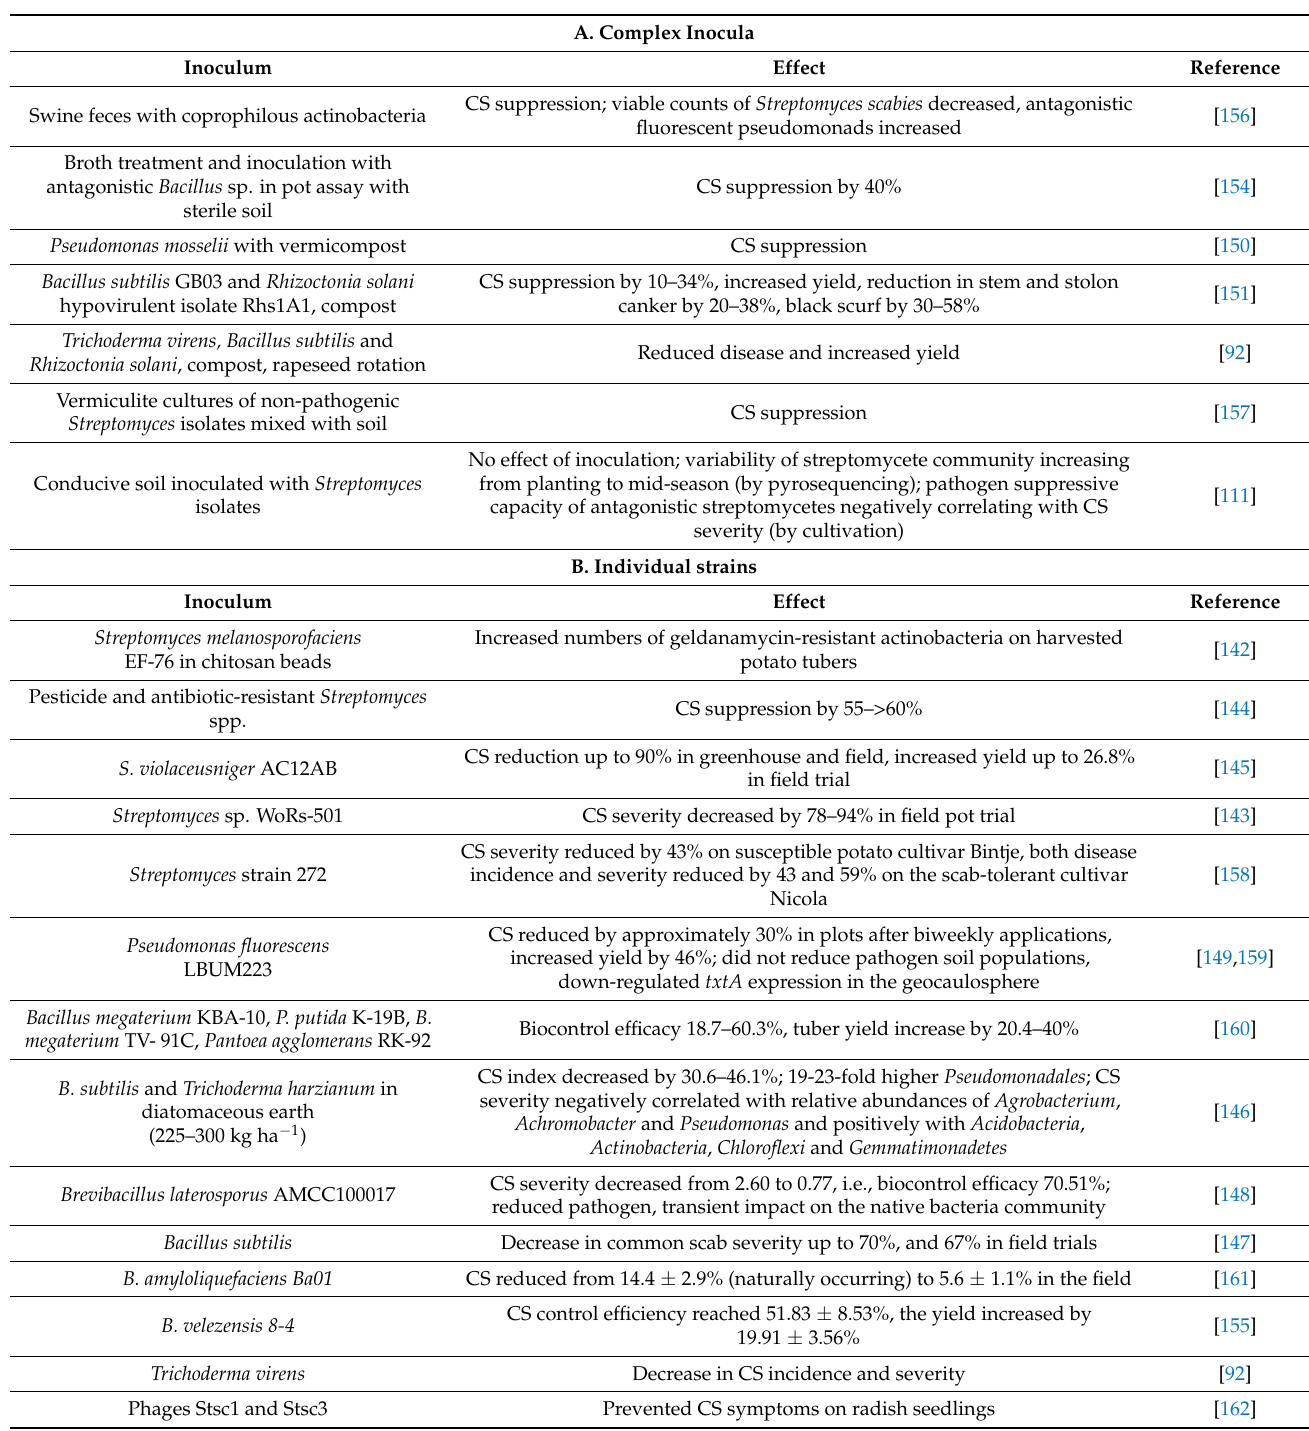
Table 4. Soil inoculation affecting CS severity, tuber yield and associated bacterial